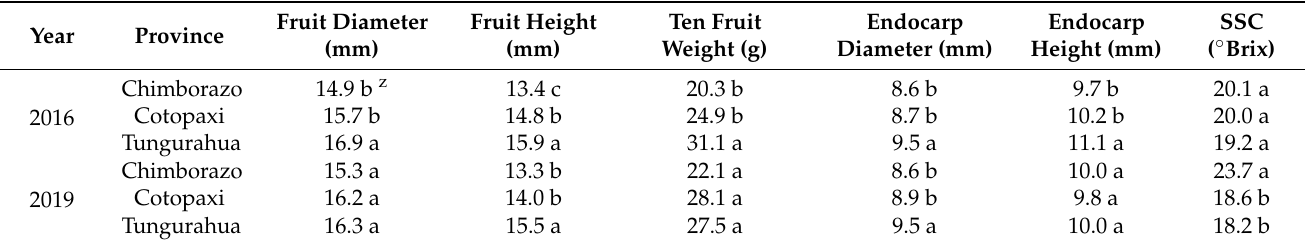
Table 4. Fruit and endocarp characteristics of P. serotina subsp. capuli, according to its provinces of origin in